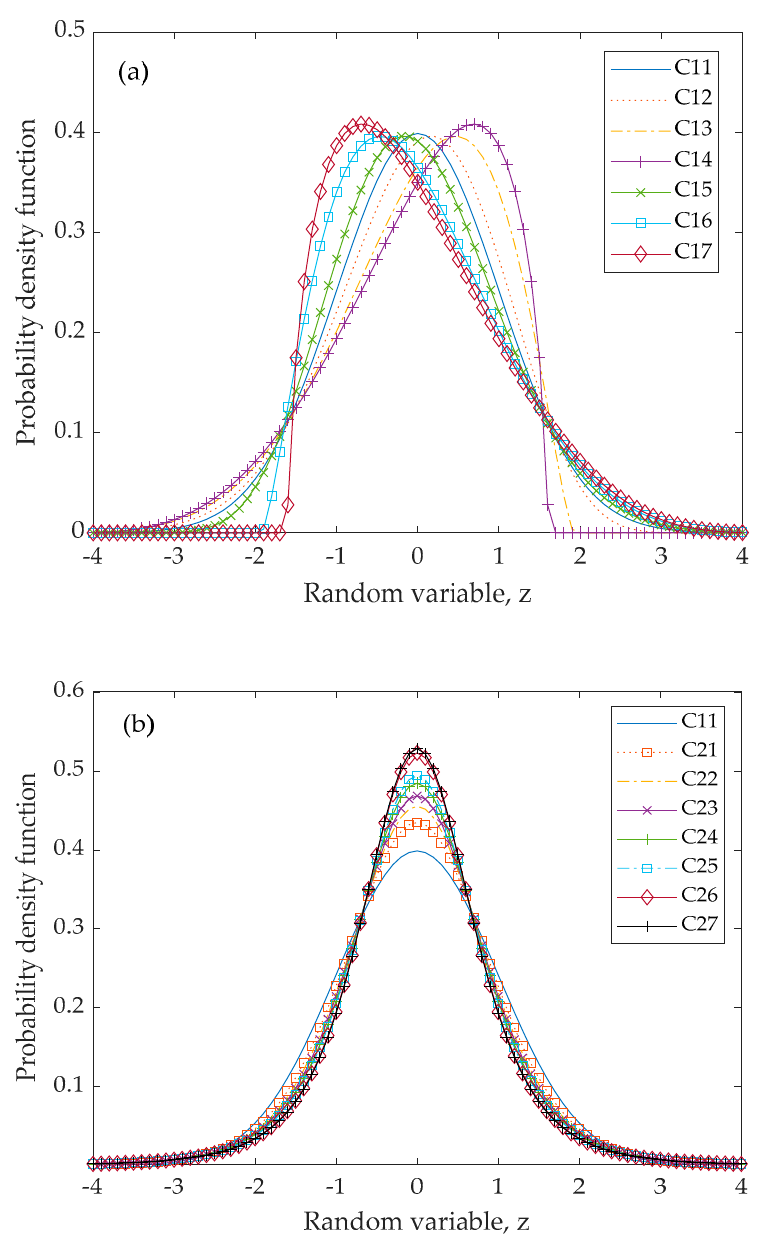
Figure 2. Example of Pearson distribution of NLFE: ( a ) effect of change in skewness, ( b ) effect of change in kurtosis.